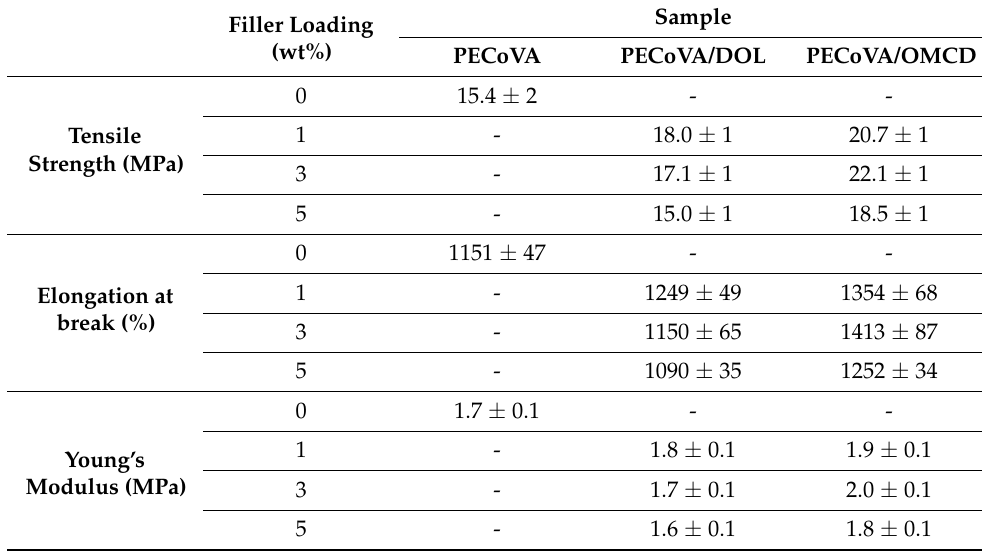
Table 5. Tensile properties of virgin PECoVA, PECoVA/DOL and PECoVA/OMCD